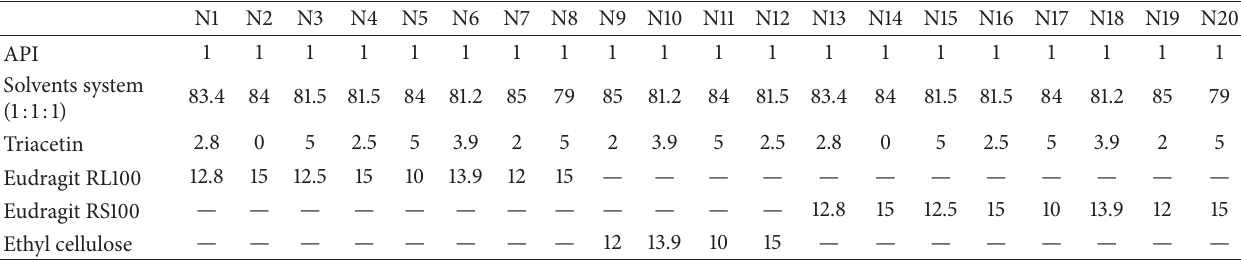
Table 1: Composition of 1% naftifine hydrochloride nail lacquers.